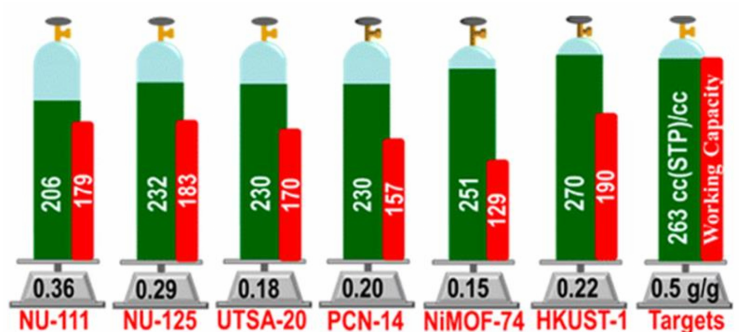
Figure 3. Methane uptake properties (green) and working capacity (red) of selected MOFs. Reprinted with permission from J. Am. Chem. Soc. 2013, 135, 11887–11894 ([107]). Copyright 2013 American Chemical